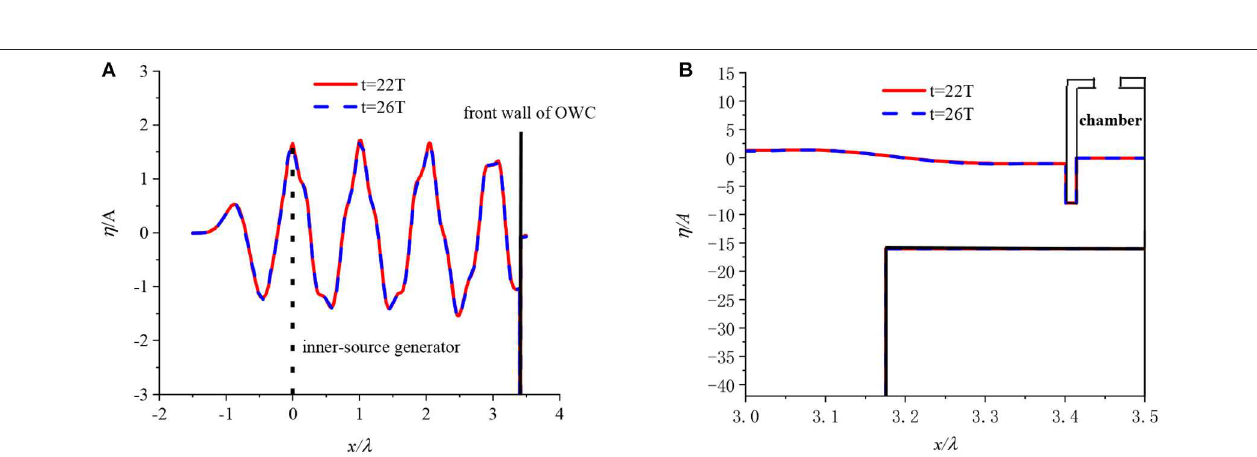
FIGURE 4 | Image of free surface elevation along the wave flume at T = 1.0s and t = 22 T and 26 T , respectively. (A) Overall view (B) enlarged view at stepped bottom.